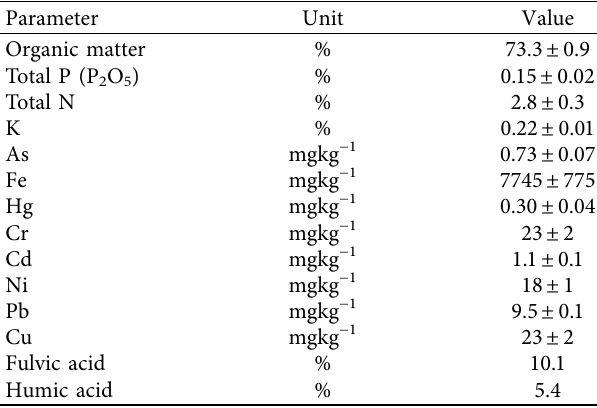
Figure 2: Applications of sapropel in different sectors of the economy (adopted from Stankevica et al. [23]). Table 1: Characteristics of the sapropel sample according to certified analysis on a fresh mass